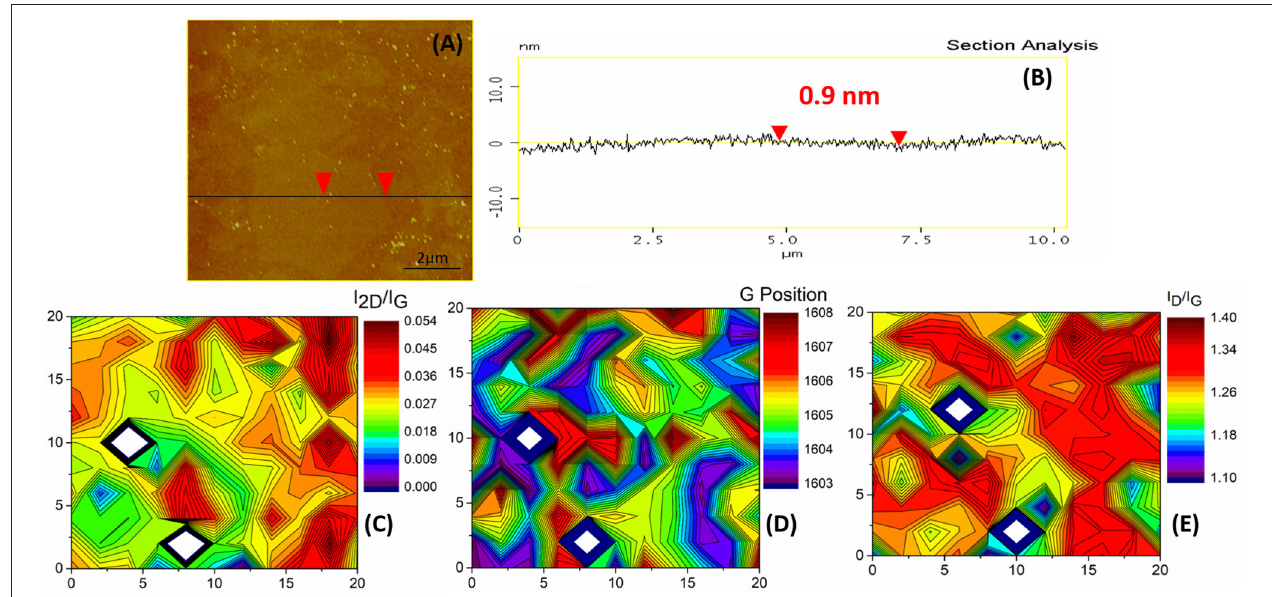
FIGURE 8 | h-G flakes onto the Si substrate. (A) A high magnification AFM image. The black line and the red arrows indicate the section and point of measurement, respectively for (B) , which is a section analysis with an indicative height measurement. (C) Raman 2D contour plot of the I 2D /I G . (D) Raman 2D contour plot of the G position. (E) Raman 2D contour plot of the I D /I G ratio. Axis dimensions in all Raman plots are in µ m.